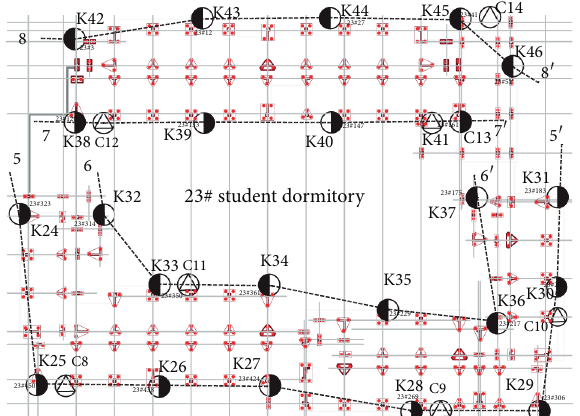
Figure 4: The investigation site with pile location layout of 23# student dormitory.